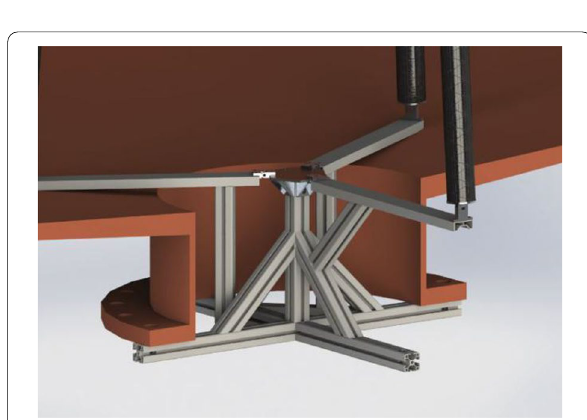
Figure 3 Supporting base